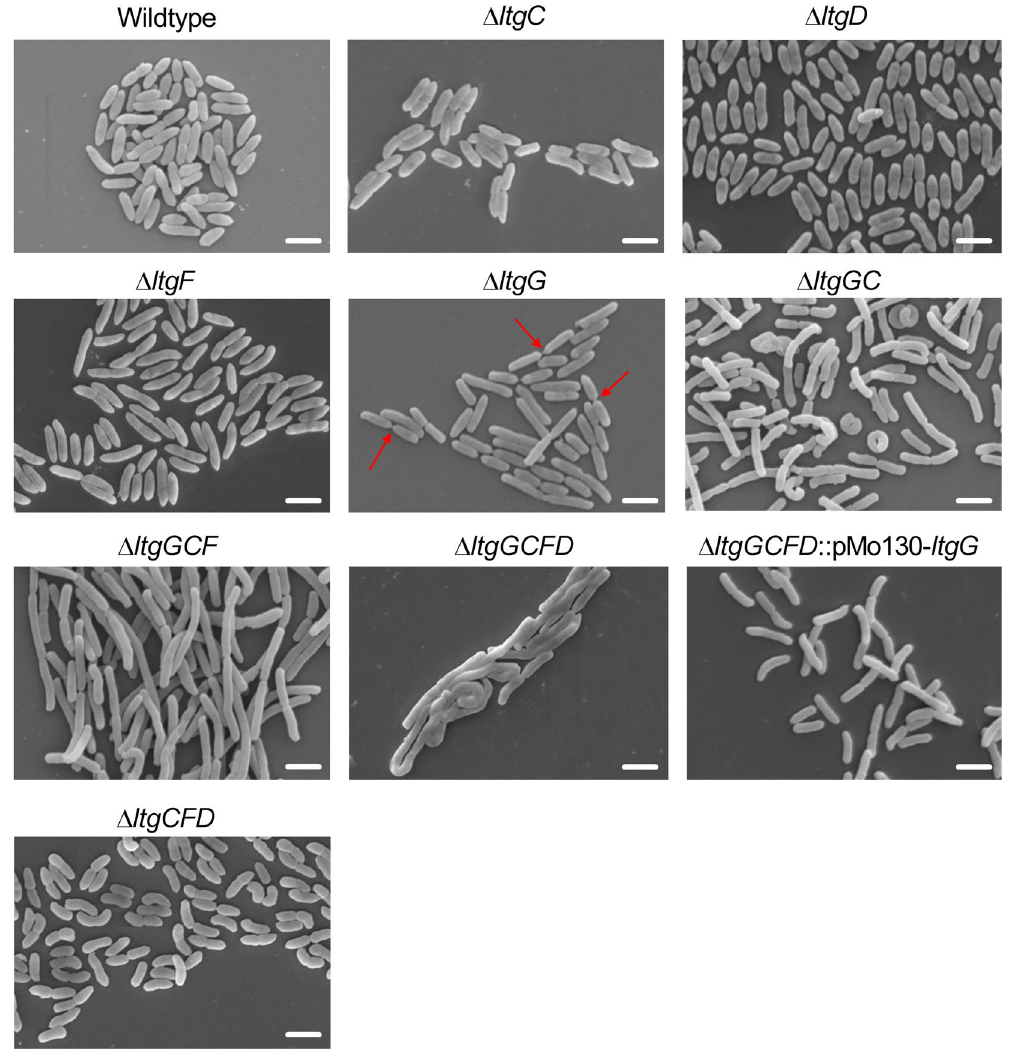
Figure 3. Deletion of ltgG results in generation of elongated cells. B . pseudomallei strains were grown to early exponential phase and fixed in glutaraldehyde as described in Methods. For assessment of morphology 10 independent fields were monitored, representative images are shown. Scale bar is 2 µ m. Examples of unseparated cells are marked with arrows.